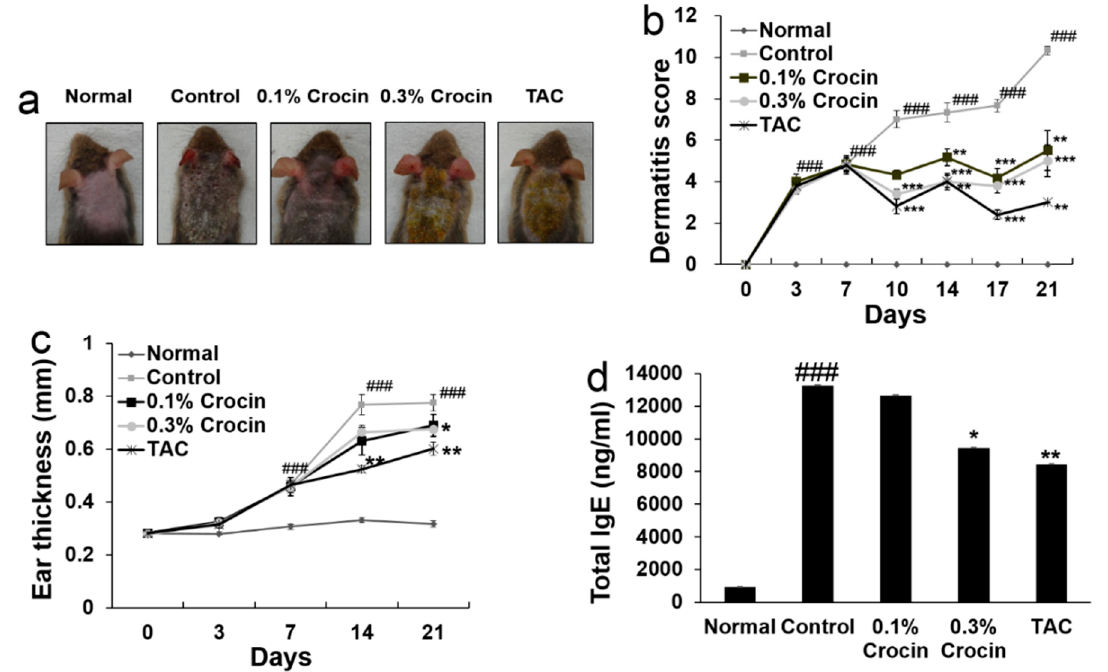
Figure 2. ( a ) Clinical features; ( b ) dermatitis severity score; ( c ) ear thickness; and ( d ) total immunoglobulin E (IgE) levels in serum. Results are expressed as mean ± standard error of the mean (S.E.M.) for six mice. Groups: Normal, no treatment group; Control, DfE-treated group; Crocin, 0.1%- or 0.3%-treated group; and TAC, tacrolimus-treated group. Key: ### p < 0.001 versus Normal group; * p < 0.05, ** p < 0.01, and *** p < 0.001 versus Control group.